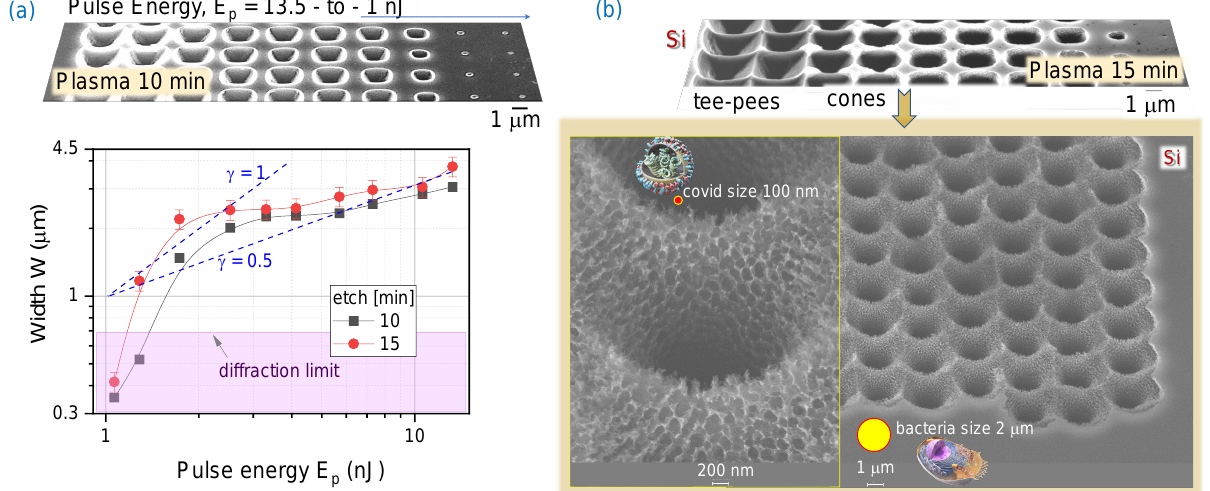
Figure 2. ( a ) The opening width of the etched tee-pee through a hole in 30 nm Cr mask ablated at different pulse energies E p . Top-insets shows SEM image after Cr mask removal following a 10 min plasma etch. ( b ) Nano-structures formed below Cr mask in the under-etch region. Etched by SF 6 :CHF 3 :O 2 at 5:1:1 flow rate